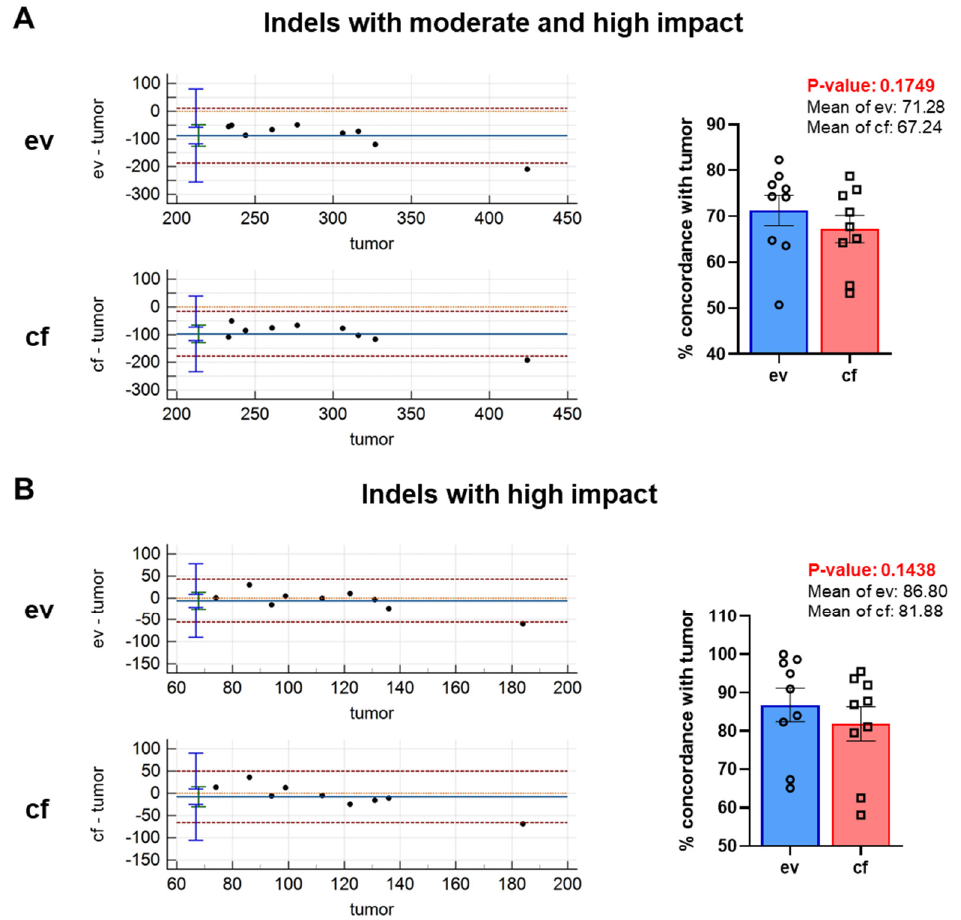
Figure 8. Stringent filtering of variants was applied to increase specificity for tumor-associated variants. Bland–Altman plots and concordance (%) of variants between tumor- and evDNA as well as between tumor- and cfDNA for ( A ) indels with moderate and high impact and ( B ) indels with high impact. Statistical tests: ( A , B ) Two-tailed paired Student t -test.